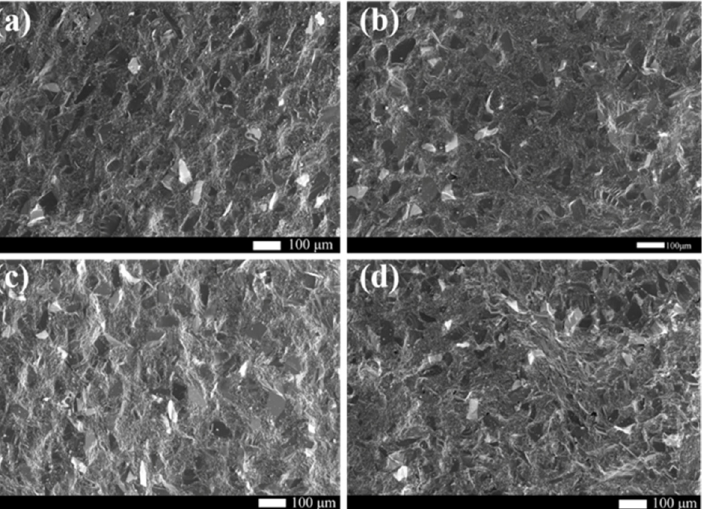
Figure 9. SEM micrographs of the fracture surface of the RBSC with different carbon content ( a ) 4 wt%CB, ( b ) 6 wt%CB, ( c ) 8 wt%CB and ( d ) 10 wt%CB.